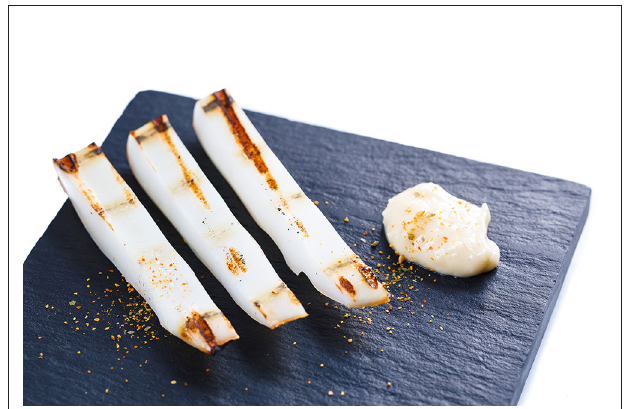
FIGURE 2 | Semi-dried squid ( ika no ichiya-boshi ), a classical Japanese dish, made of Loligo forbesii with ponzu mayo and shichimi. Photo: permission by and courtesy of Jonas Drotner Mouritsen.